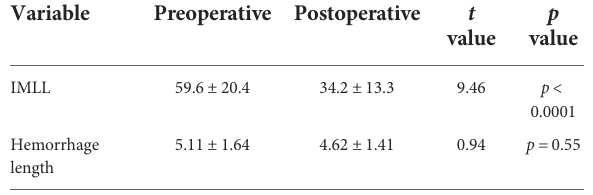
TABLE 1 Demographic and clinical characteristics of patients.